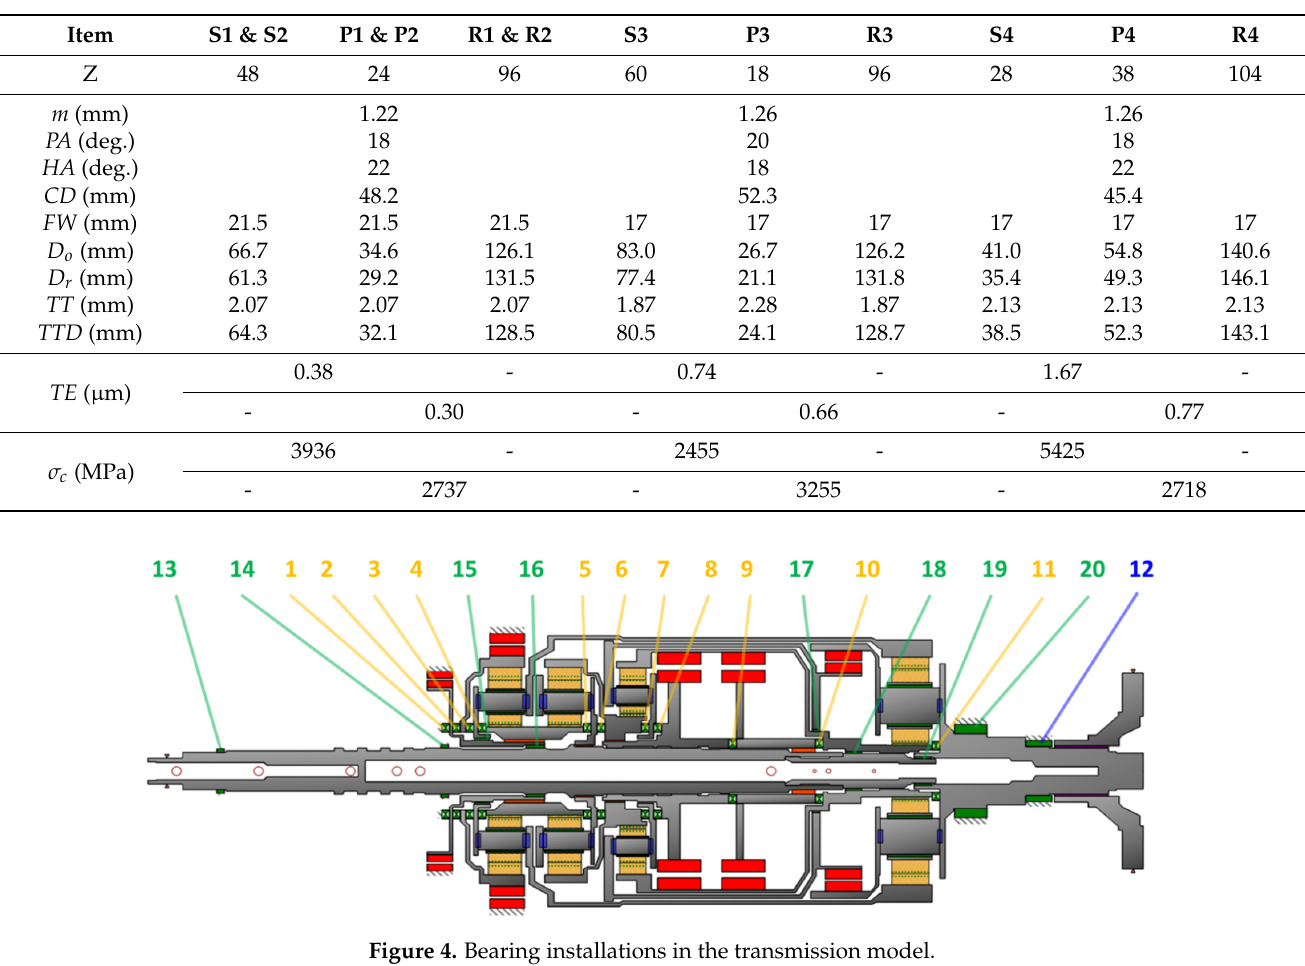
Table 3. Designs of planetary gear sets consisting of the example transmission model.